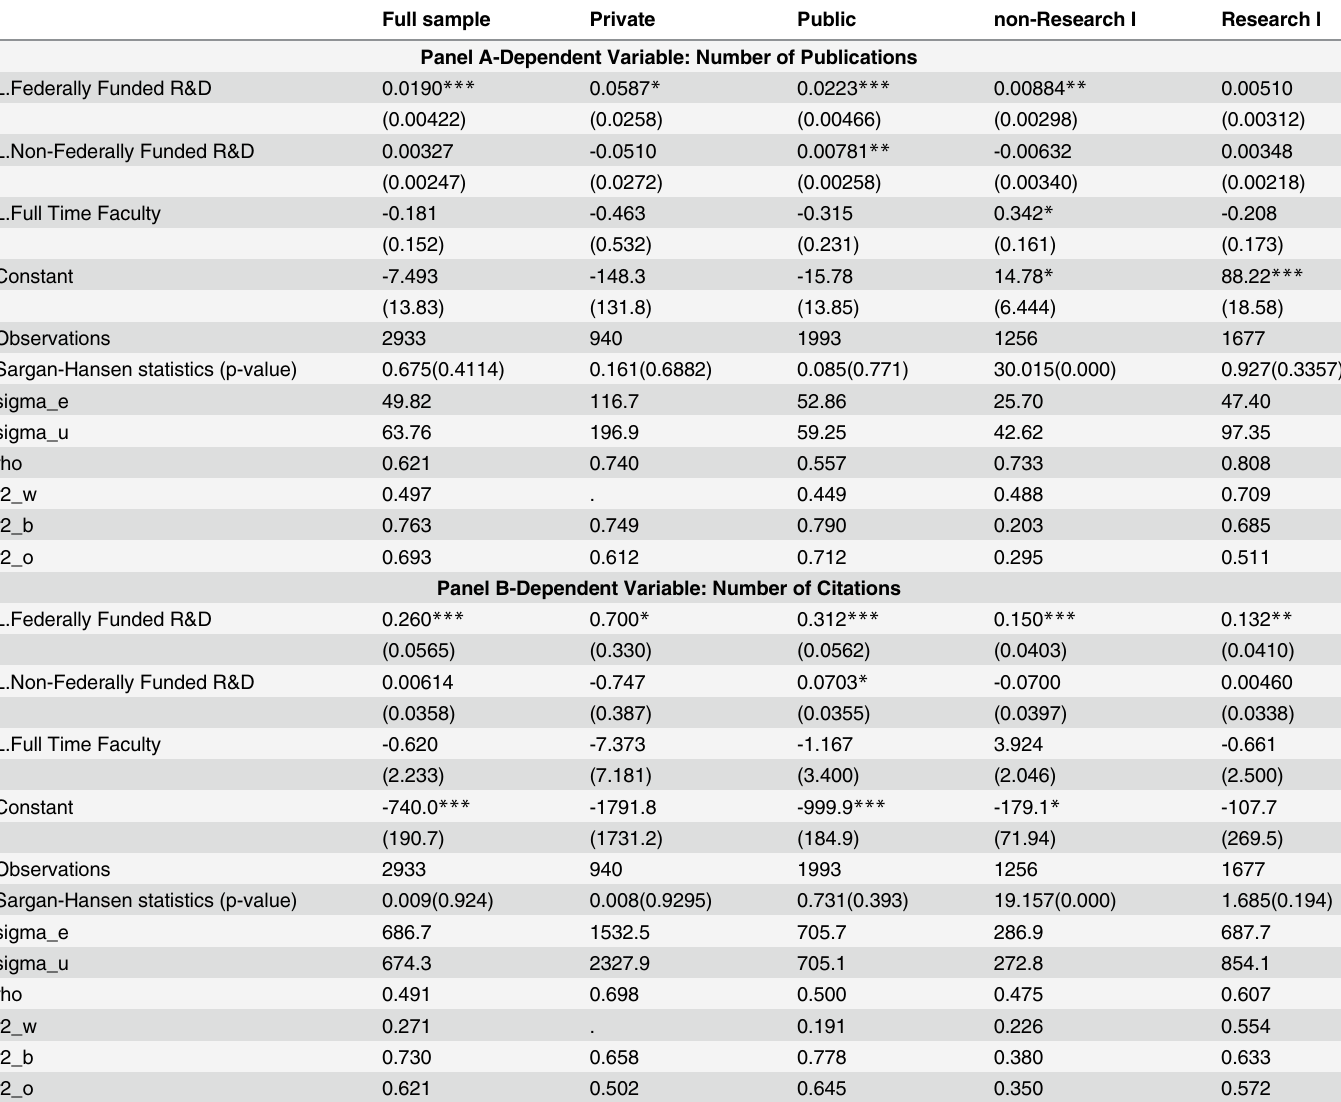
Table 5. IV Regressions. Determinants of Publications, Citations, by University Type. Instruments: Math & Physics Federal R&D, Math and Physics non-federal R&D, Fall Enrollment. Full sample